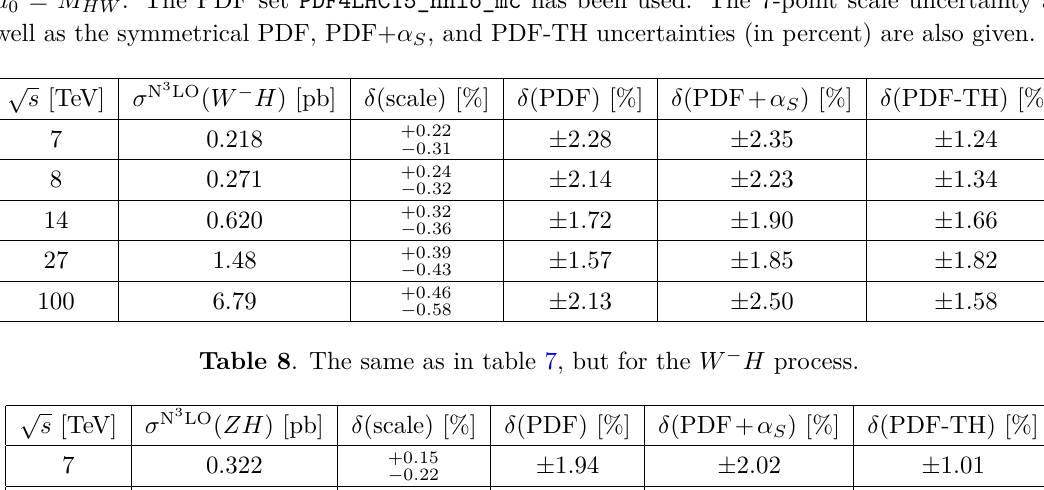
Table 7 . Total cross section for associated Higgs production with a W + boson at N 3 LO in QCD, √ at a proton-proton collider at various c.m. energies s in TeV for a dynamical central scale choice µ 0 = M HW . The PDF set PDF4LHC15_nnlo_mc has been used. The 7-point scale uncertainty as